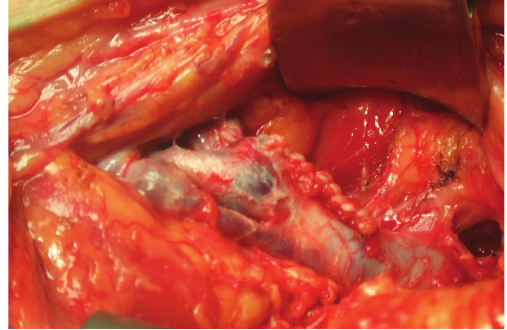
Figure 6: Intraoperative image showing tangential aneurysmec- tomy and lateral